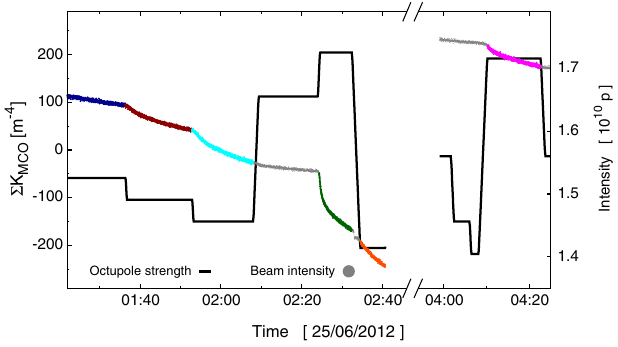
FIG. 4. Sequence of measurements performed during the experimental session. The evolution of the beam intensity and of the MCO magnets ’ strength is shown. The color is used to indicate the data selected for the analysis presented in the rest of the paper.